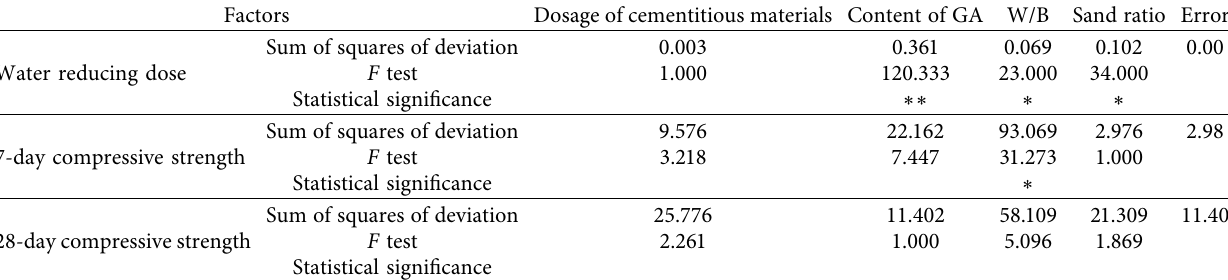
Table 11: Results of variance analysis of